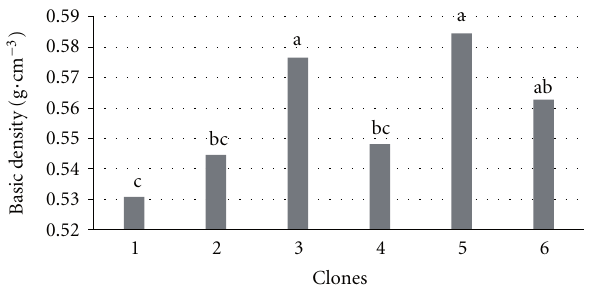
Figure 1: Mean values of wood density of Eucalyptus spp. clones, g · cm − 3 . Standard deviation = 0.02; variation coe ffi cient = 1.6%. Means followed by same letter do not di ff er at 5% probability by Tukey